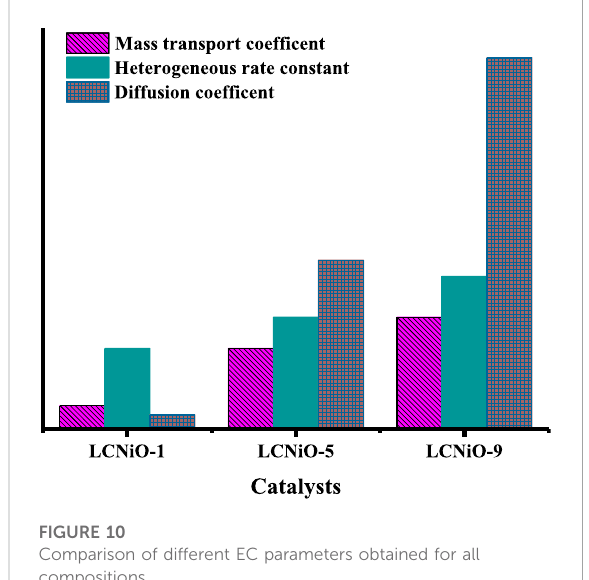
FIGURE 10 Comparison of different EC parameters obtained for all